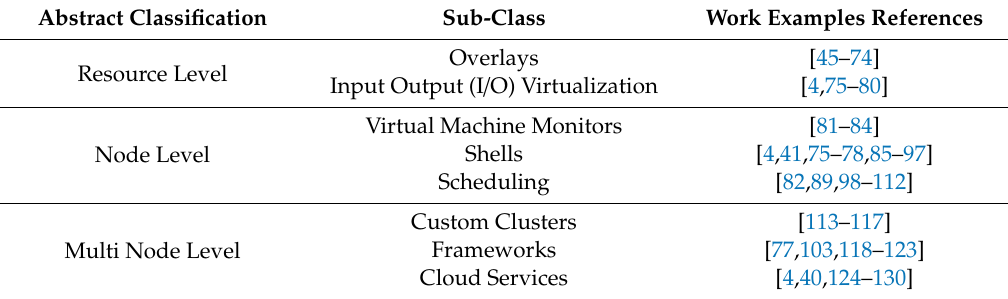
Table 3. Classification of FPGA Virtualization adopted from